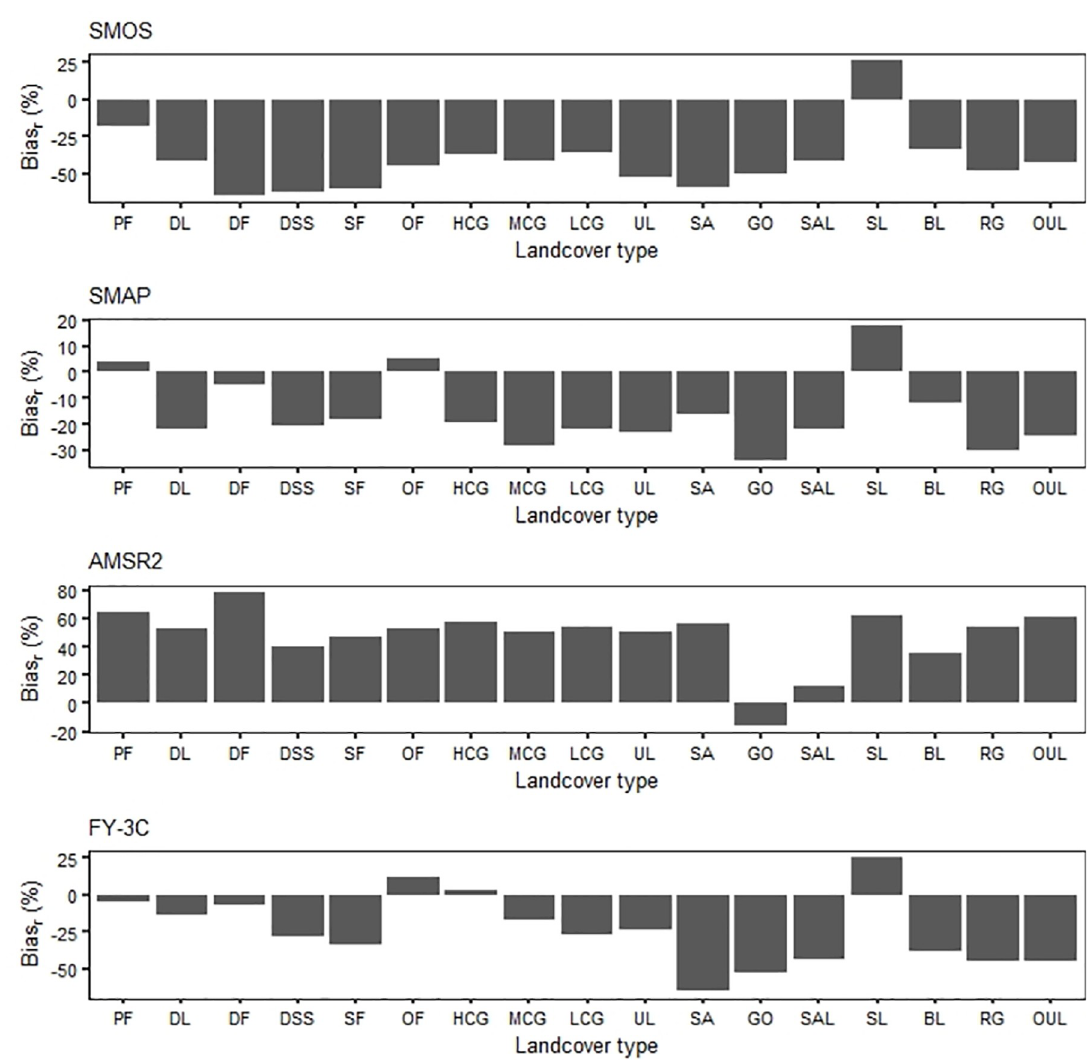
Fig 5. Histograms of Bias r for different landcover types; the abbreviations are the same as for Fig 4.